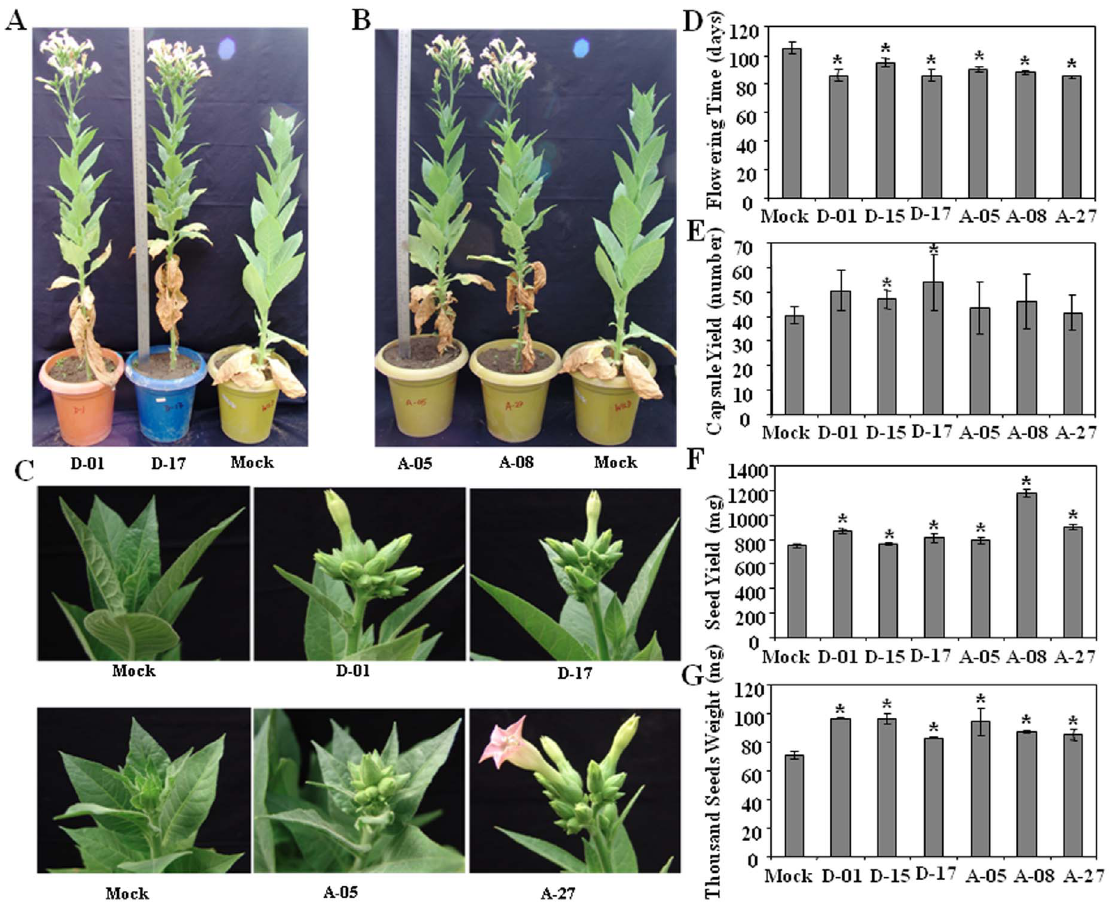
Figure 3. Morphological characterization and yield parameters of CsDFR and CsANR overexpressing transgenic lines vis-a`-vis mock tobacco plants. CsDFR and CsANR overexpressing transgenic lines were longer than mock tobacco plants (A, B). Close up views showing early flowering in CsDFR and CsANR transgenic lines compared to mock tobacco (C). The CsDFR and CsANR overexpressing transgenic lines produced early flowering as compared to control tobacco plants (D). The capsule yield (E), seed yield (F) and seed weight per thousand seed (G) in CsDFR and CsANR overexpressing transgenic lines as compared to mock tobacco plants. Mean 6 SD from three replications are shown. Statistical significance is indicated as (*) for P ,